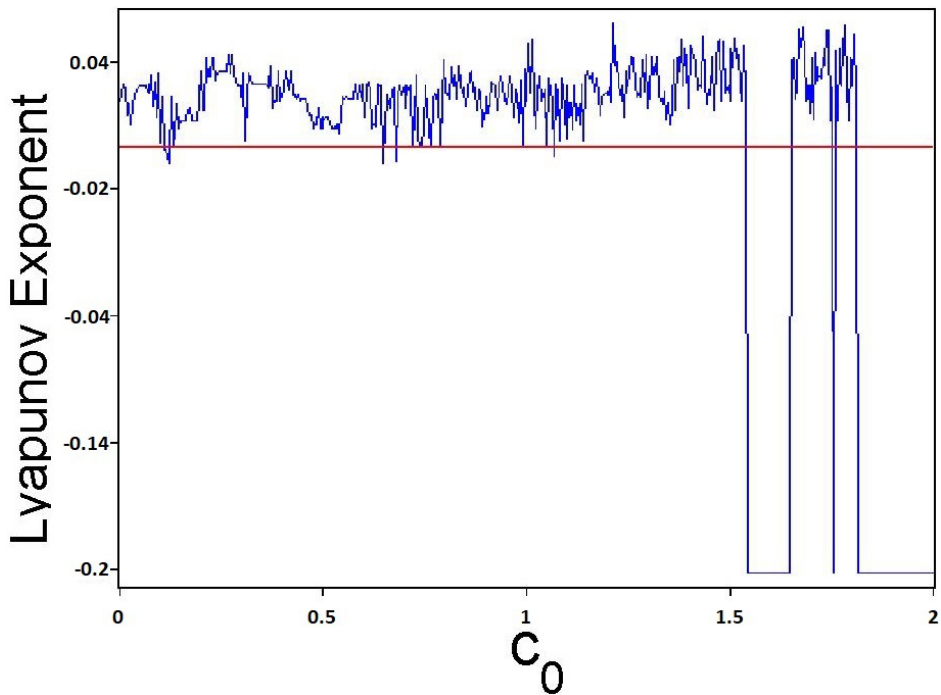
Figure 1. The 3D piecewise chaotic map bifurcation diagram of x plotted versus c 0 0.29 and c 2 = 0.9. c 1 = − −